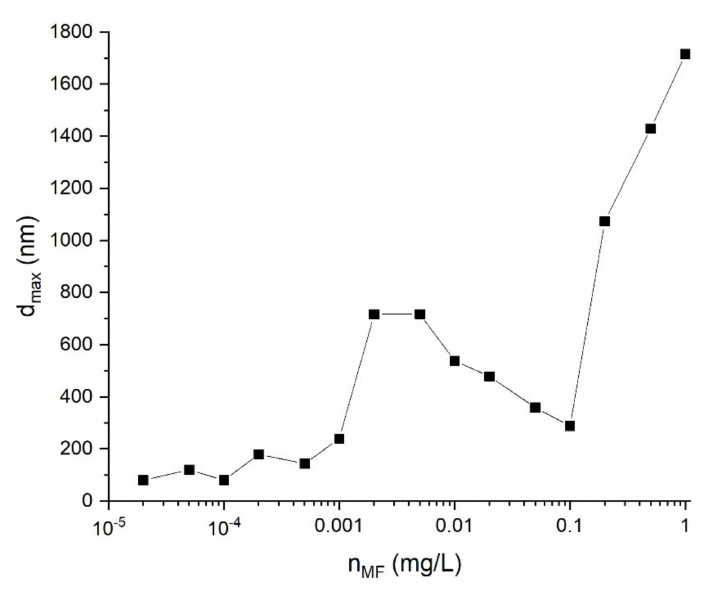
Figure 7. Dependence of the typical size of aggregates in albumin/magnetic fluid mixture on magnetic fluid concentration. d max is the particle size corresponding to the largest mode of the intensity